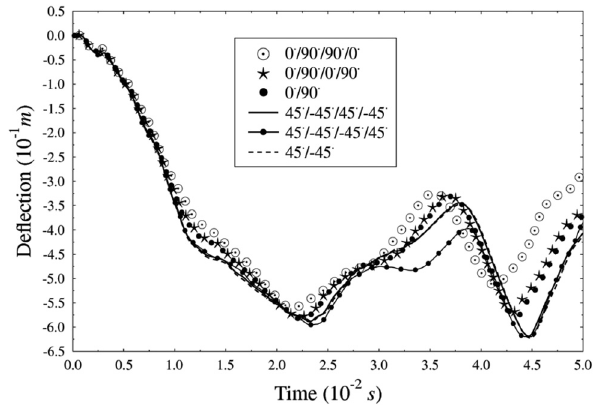
Figure 13: Nonlinear dynamic time histories of CNTFPC cylindrical panels for di ff erent layup angle